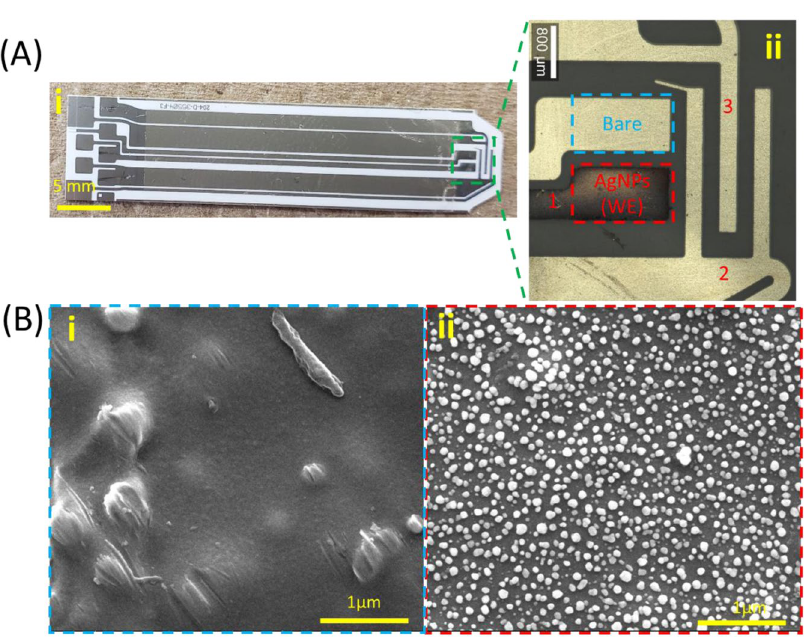
Figure 2. The fabrication and characterization of the test strip. ( A ) the photo (i) and optical imaging (ii) of commercial glucose test strip before (i) and after (ii) electrodeposition of AgNPs (inset: 1-working electrode; 2-counter electrode; 3-reference electrode); ( B ) SEM images of bare test strip (i) and AgNP-coated test strip